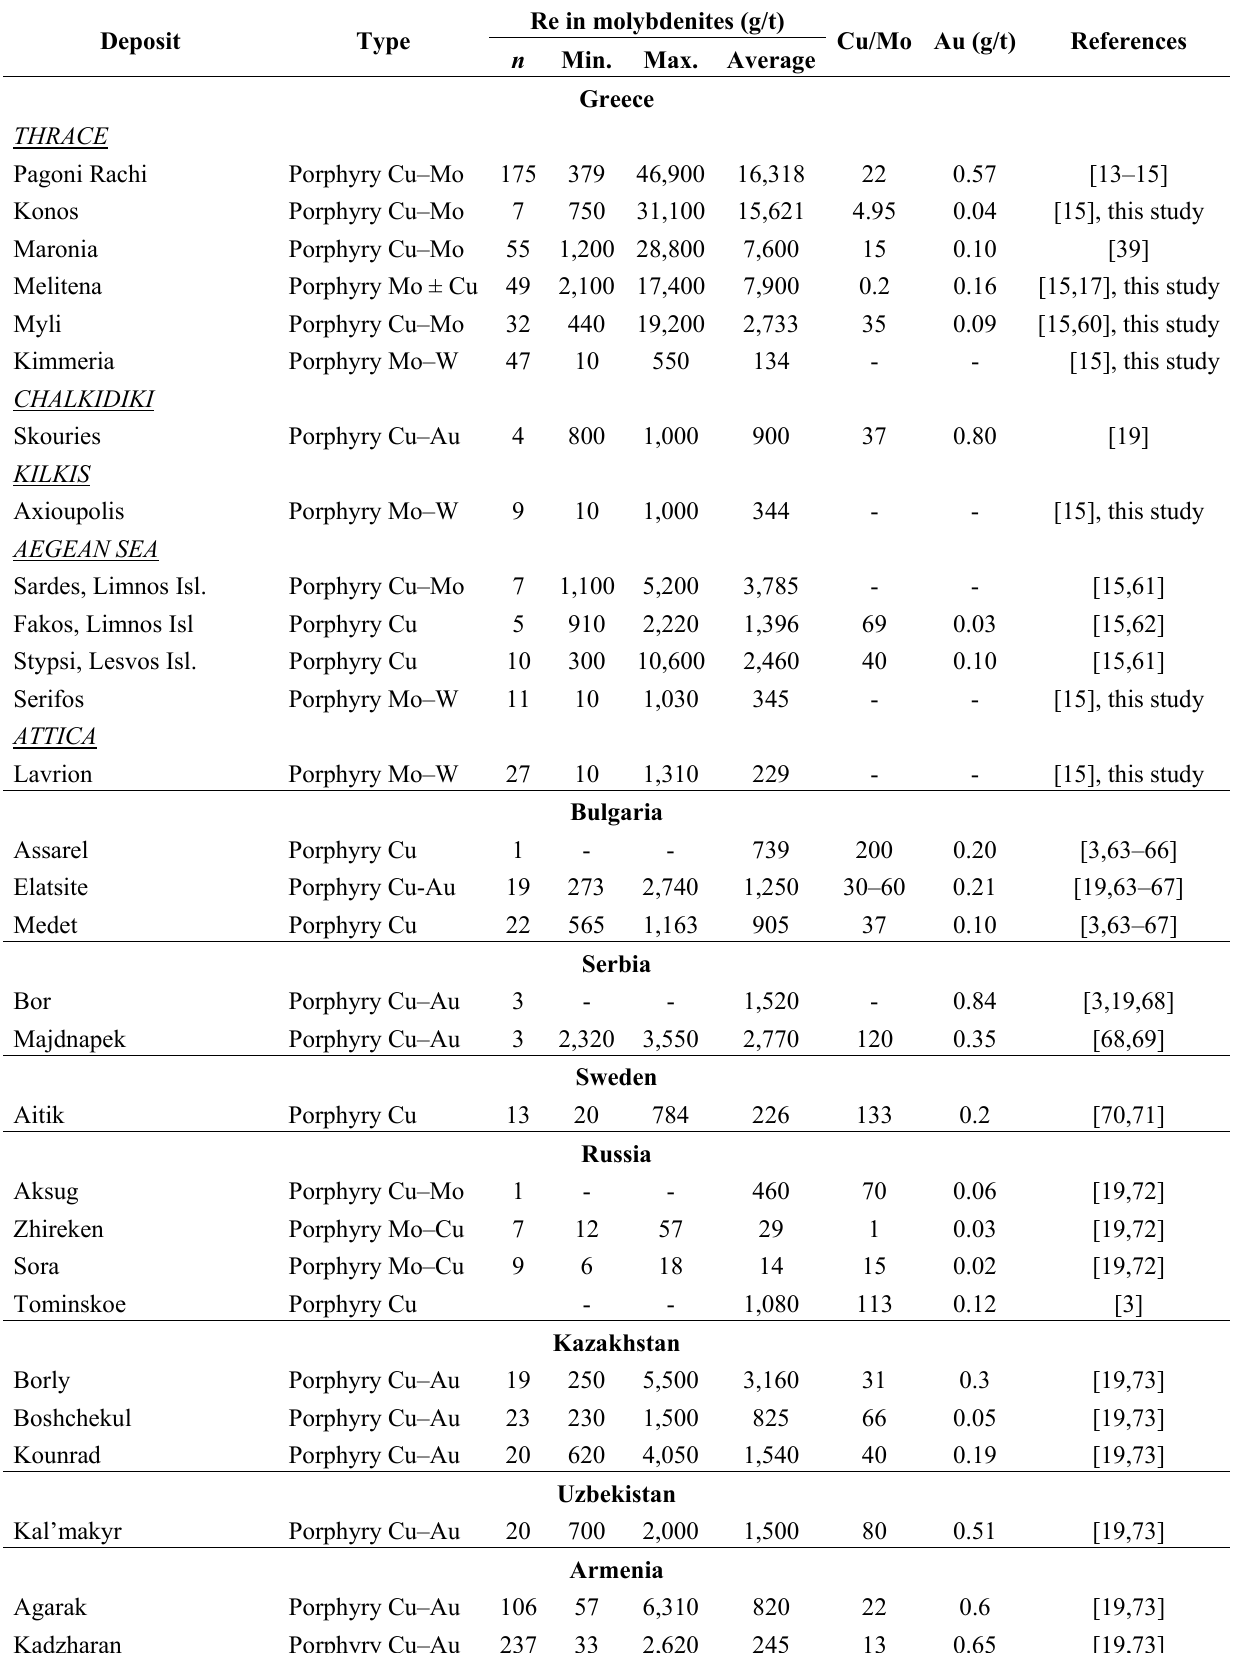
Table 1. Rhenium content of molybdenite from porphyry-type deposits in Greece and elsewhere. Cu/Mo ratios and Au contents are also